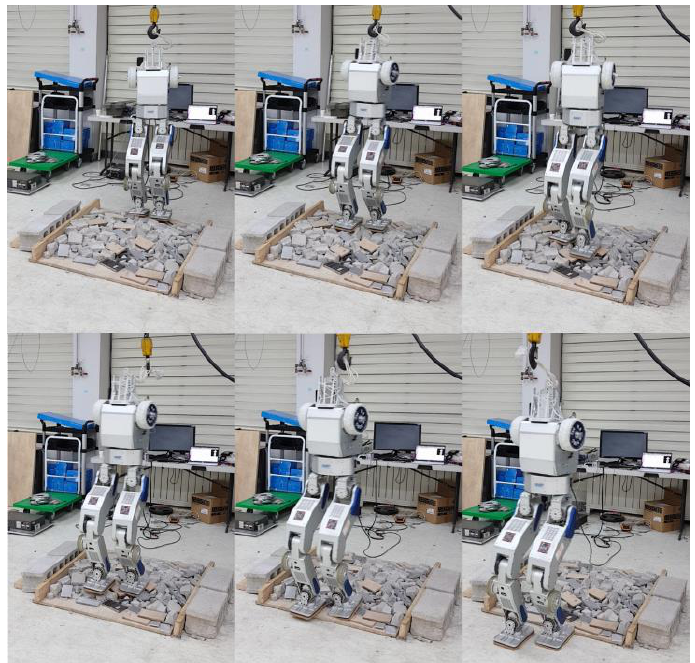
Figure 22. Snapshots from the walking experiment on a stony area.